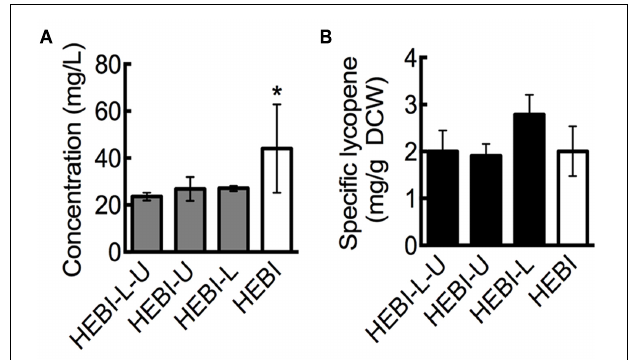
FIGURE 2 | Effect of leucine and uracil auxotrophies on lycopene production. (A) Lycopene titer for strains with and without leucine and uracil auxotrophies. (B) Specific lycopene content (mg lycopene/g DCW) for strains with and without leucine and uracil auxotrophies. Strains were grown for 4 days in 25 mL of YPD10 at 30 ◦ C in baffled shake flasks. Dry cell weight produced by each strain: HEBI-L-U 2.4 ± 0.4 g/L, HEBI-U 2.8 ± 0.2 g/L, HEBI-L 2.0 ± 0.4 g/L, and HEBI 4.3 ± 0.8 g/L. Statistical significance from the HEBI-L-U strain is indicated by “ ∗ ”. HEBI indicates the following